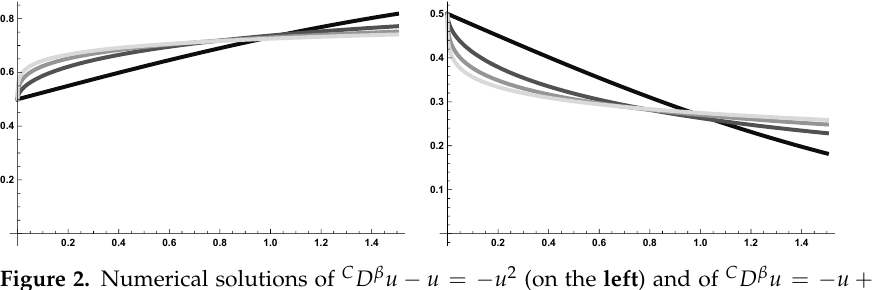
Figure 2. Numerical solutions of C D β u − u = − u 2 (on the left ) and of C D β u = − u + u 2 (on the right ) with u 0 = 1/2 and β = 1,1/2,1/3,1/4. Darker lines correspond to bigger β ’s.